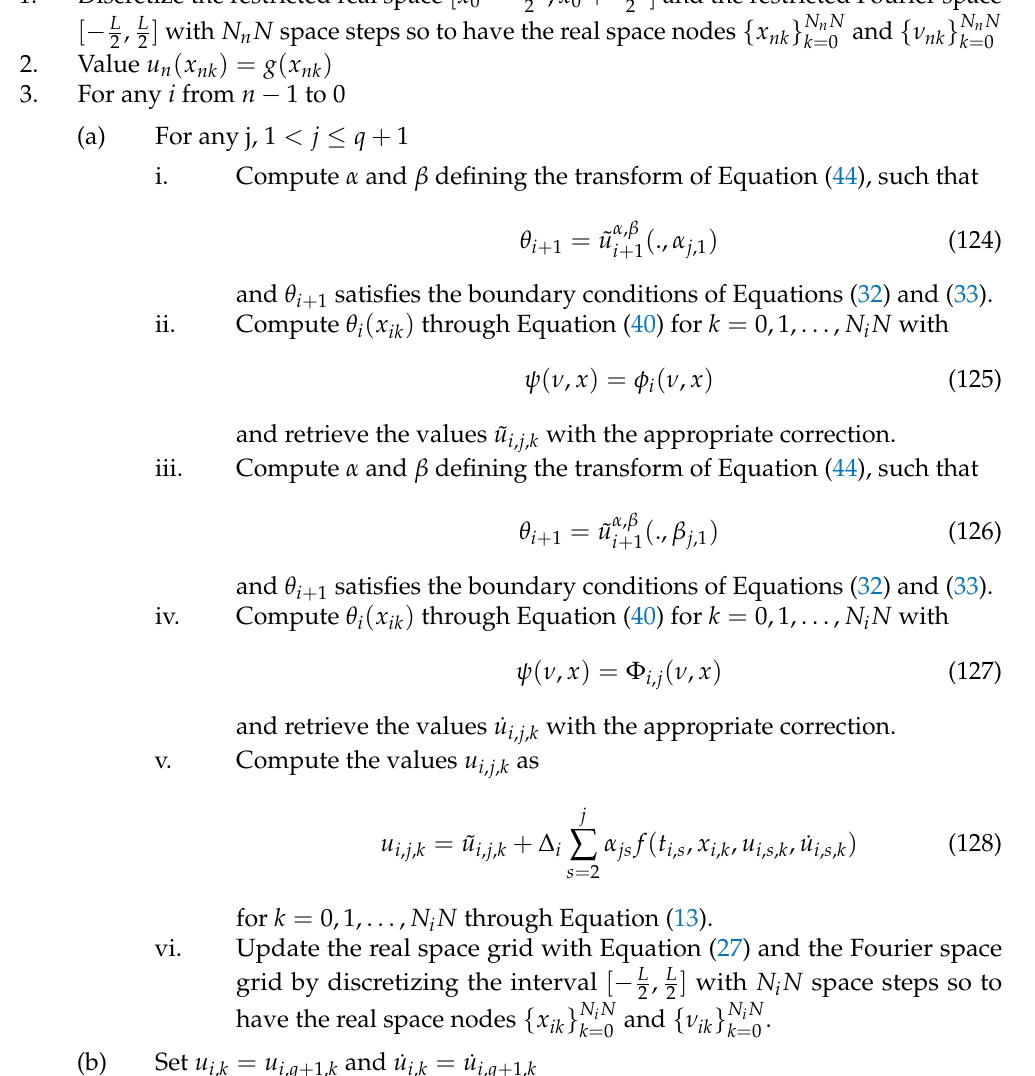
Algorithm 2 Fourier Interpolation Method on Alternative Grid for q -stage Runge–Kutta